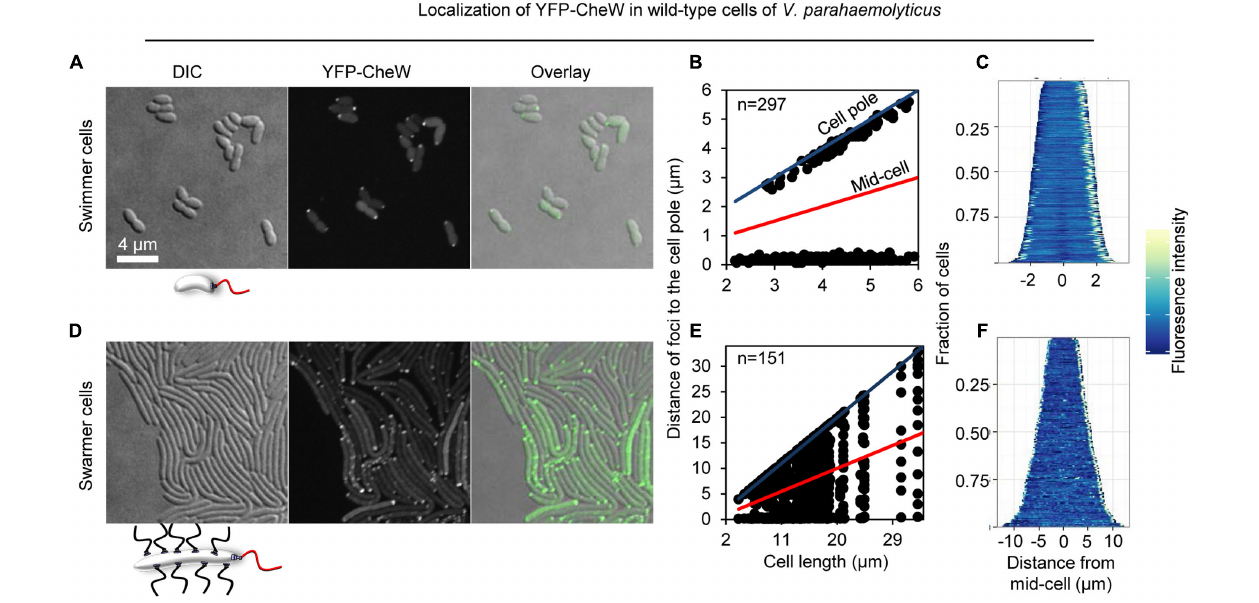
FIGURE 2 | Intracellular localization of chemotactic signaling arrays in swimmer and swarmer cells of V. parahaemolyticus . Intracellular localization of YFP-CheW in wild-type swimmer (A–C) and swarmer cells (D–F) of V. parahaemolyticus . (A,D) Microscopy showing the intracellular localization of YFP-CheW in swimmer (A) and swarmer cells (D) . (B,E) Graph depicting the distance of YFP-CheW foci from the cell poles as a function of cell length in swimmer (B) and swarmer cells (E) . (C,F) demographic analysis showing the fluorescence intensity of YFP-CheW along the cell length in a population of V. parahaemolyticus relative to cell length in swimmer (C) and swarmer cells (F)